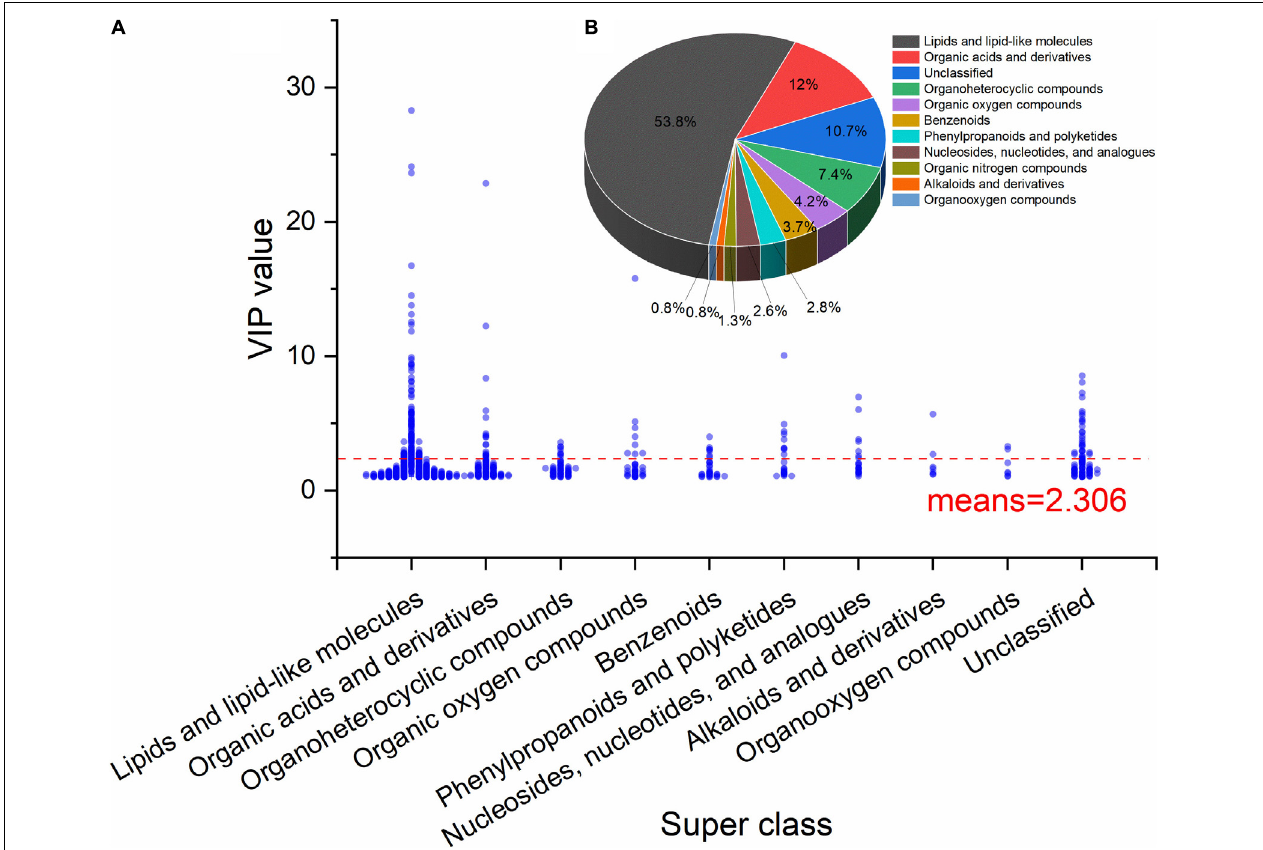
FIGURE 3 | Distribution of variable importance in the projection (VIP) values and classification of the differentially expressed metabolites in the comparison of NLQS with VQS in the honeybee Apis mellifera . (A) Scatter plot of the VIP distribution in each superclass of metabolite. The red dashed line represents the population mean value (2.306) of the differentially expressed metabolites. (B) Pie chart of the proportion of each superclass of metabolite. The superclass of lipids and lipid-like molecules accounted for 53.8%, followed by organic acids and derivatives at 12.0% and unclassified at 10.7%.